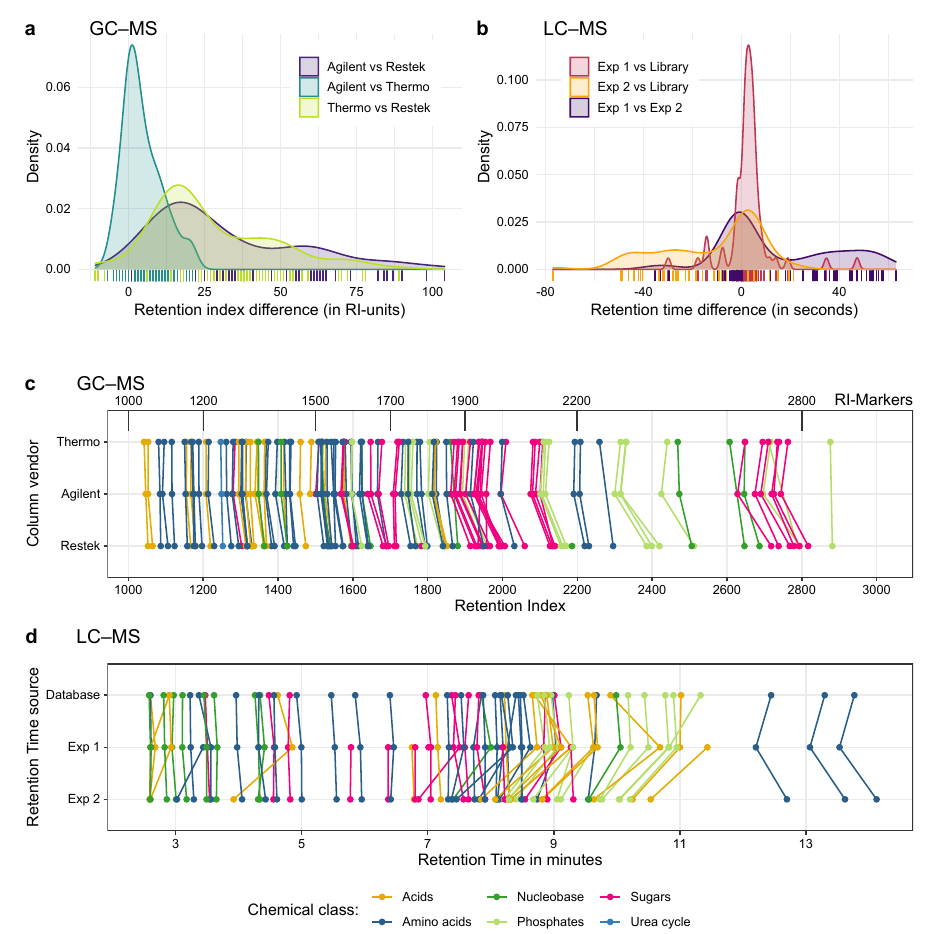
Figure 5. Application of the Ident-Mix for retention validation and compound identification by GC–MS and LC–MS. ( a , c ) Testing retention of metabolites by GC–MS with three GC columns (same polarity, different vendors) and identical machine and temperature program. ( b , d ) Testing retention of metabolites by LC–MS with two different LC columns (same make and model) and identical machine solvent gradient. ( a ) Histogram showing the RI differences for the GC-experiment, overall the columns from Agilent and Thermo are the most similar. ( b ) Histogram showing the rt-differences for the LC-experiment, here experiment 1 matches the database entries more closely than the second experiment. ( c ) Retention indices of compounds in the GC-experiment for the three setups. Coloured lines connect the same metabolite, black lines denote RI-markers. If a point is missing, no peak was detectable. ( d ) Retention times of compounds in the LC experiment for the database and two measurements. Coloured lines connect the same metabolite, if a point is missing no peak was detectable or the metabolite was not present in the in-house database. Overall RT values from experiment 1 are closer to the library entries than experiment